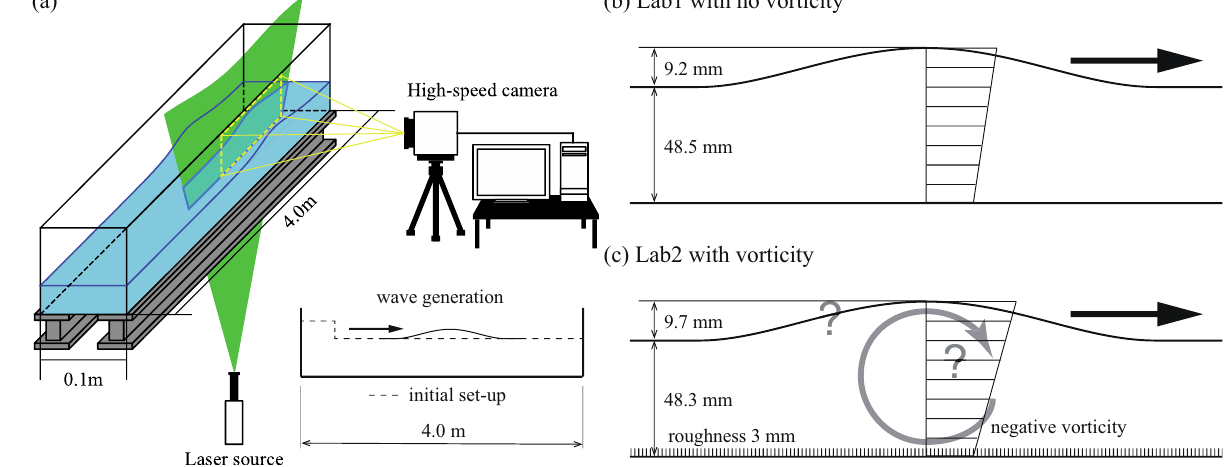
Figure 1. Laboratory experiments. ( a ) Schematic diagram of the laboratory experiments. A laser sheet was inserted through the bottom slit. ( b ) Lab1 with no vorticity. ( c ) Lab2 with